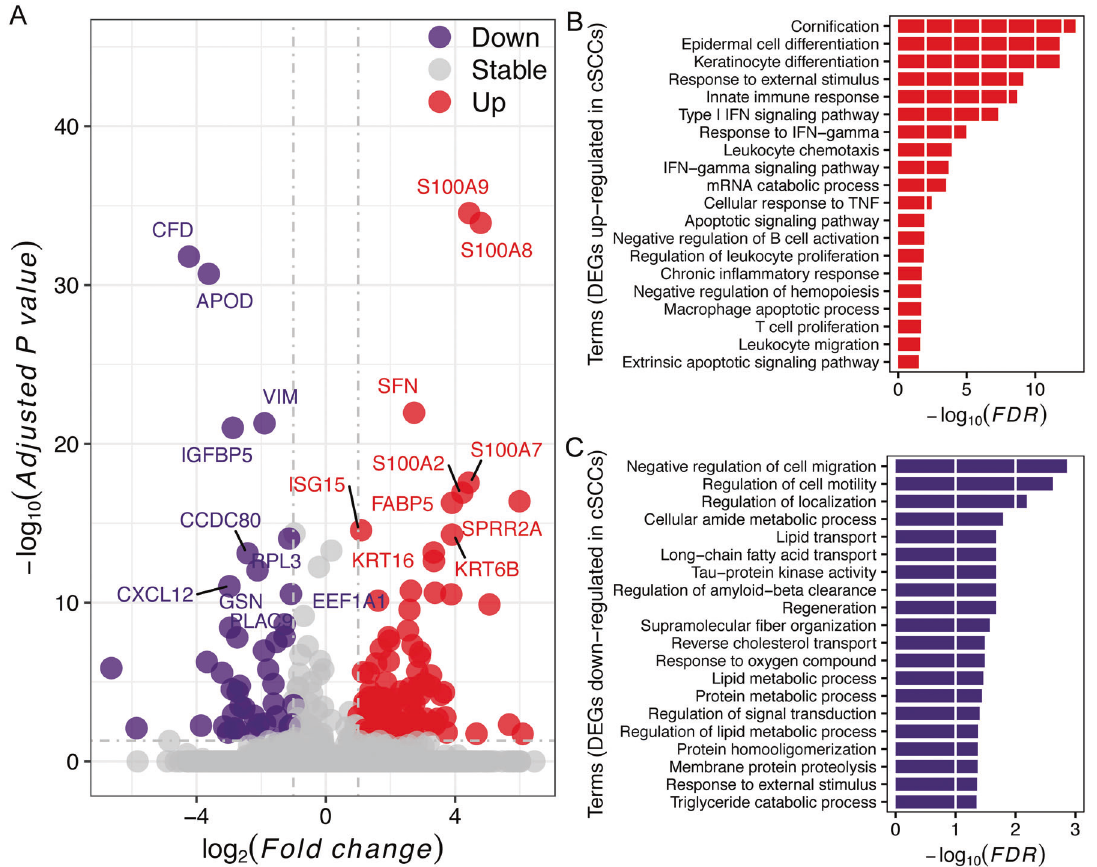
Fig. 2 Dysregulated genes and biological processes in cSCC. A Volcano plot for DEGs identi fi cation between KCs and cSCCs. B Biological processes annotated by upregulated genes in cSCCs. C Biological processes annotated by downregulated genes in